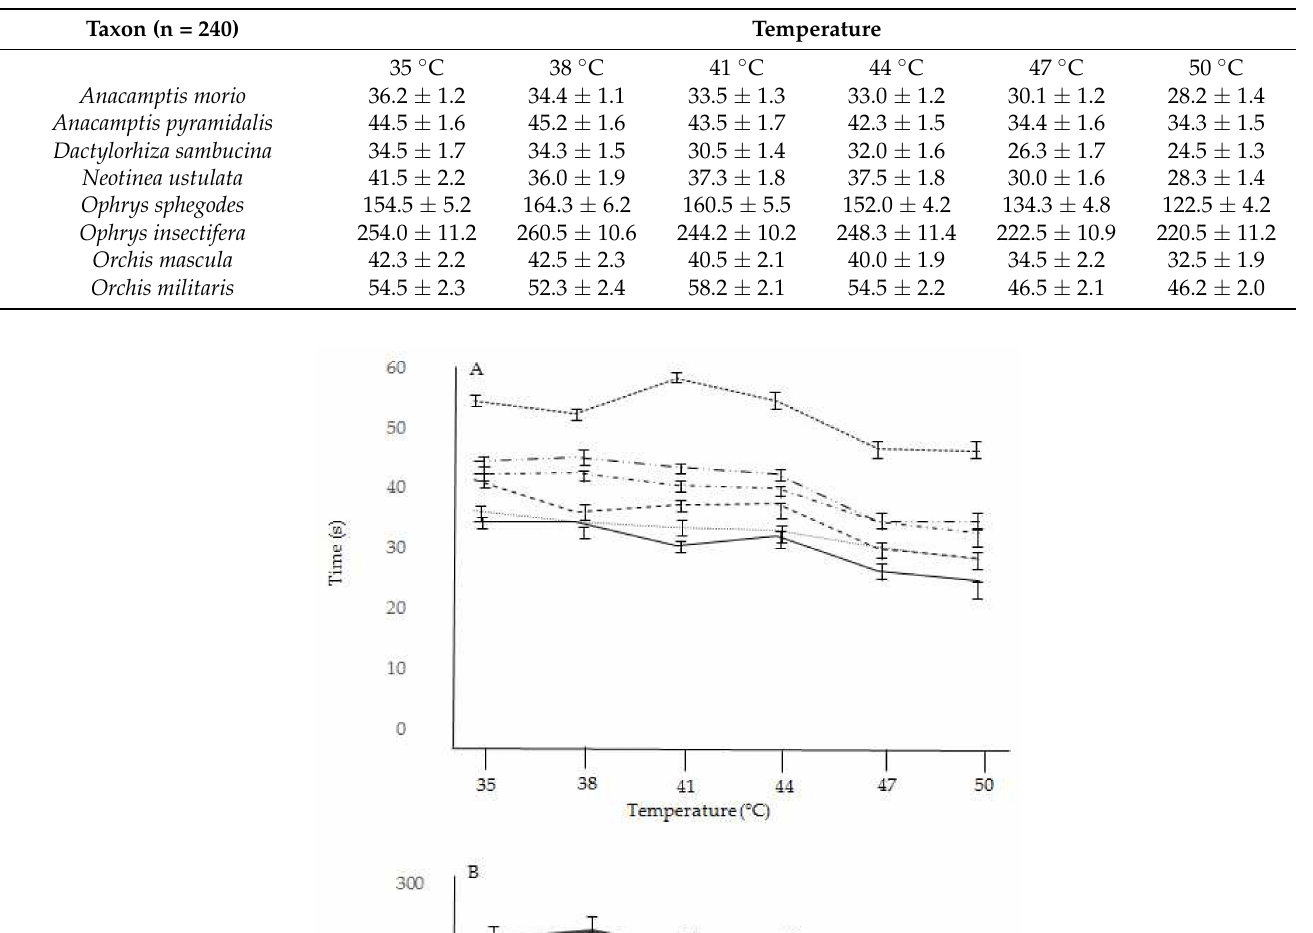
Table 2. Mean ± SE of reconfiguration times (sec) for orchid pollinaria stored at different temperatures. n = sample size.